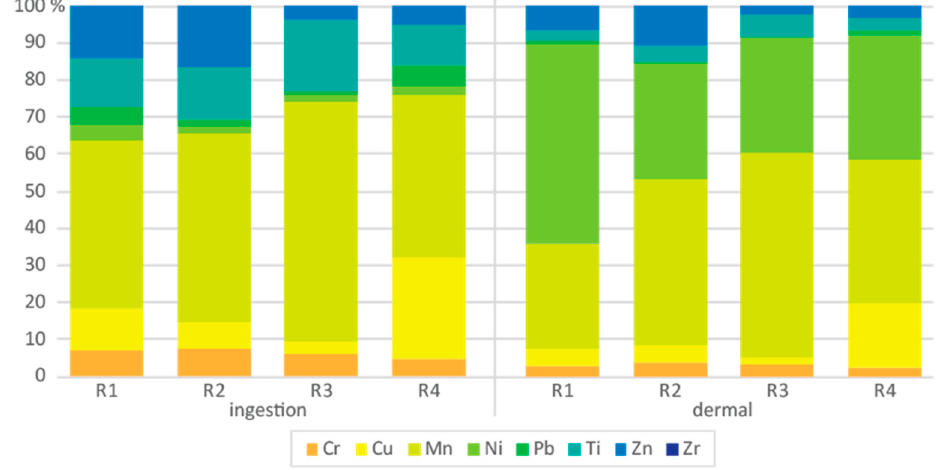
Figure 4. Rhizosphere soil hazard quotient (HQ) by ingestion and dermal contact for children (relative quantification, in %).